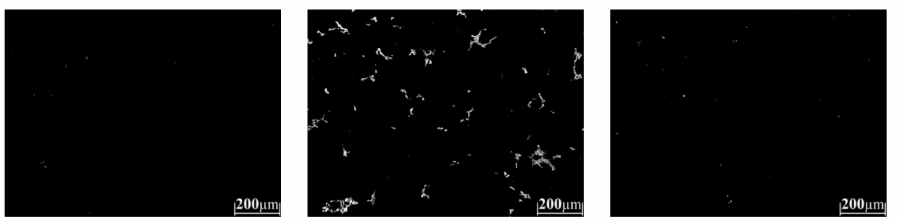
Figure A6. Etched microstructure with ammonium persulfate reveals the carbides phase (white regions) of the ductile iron alloyed with 0.2 wt % V for different lobes and regions.